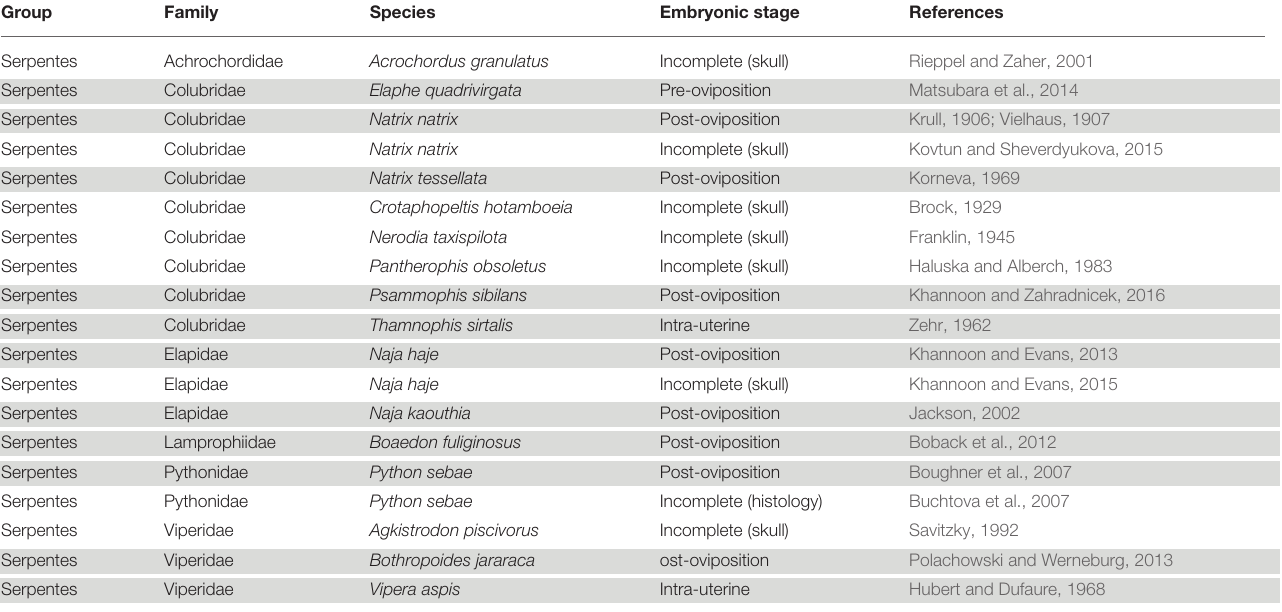
TABLE 2 | Summary of complete and incomplete embryonic staging data available for